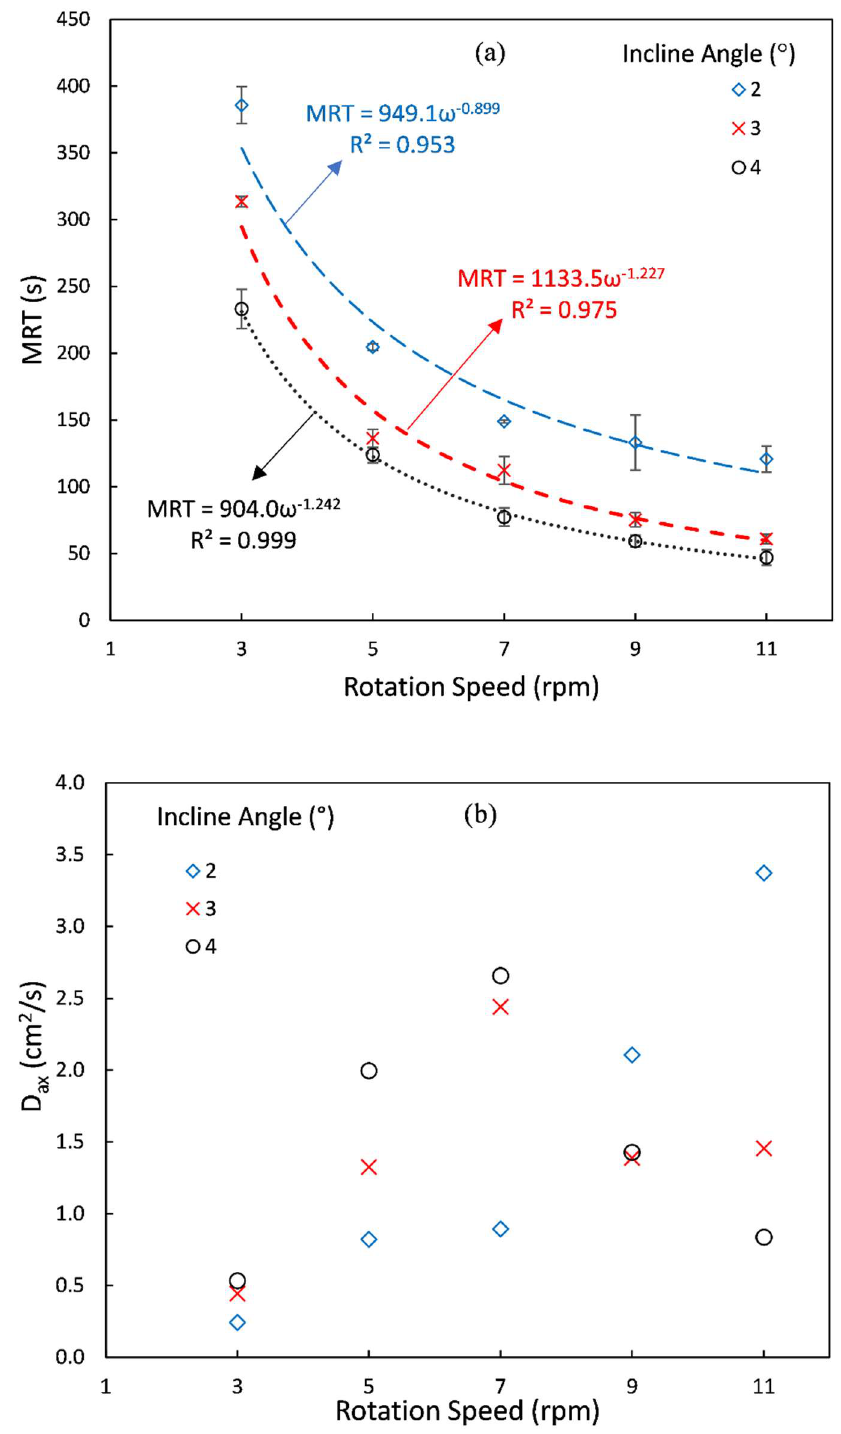
Figure 6 . Effect of rotation speed on ( a ) MRT ( b ) axial dispersion coefficient at 1.08 cm 3 /s for 6 mm cube.